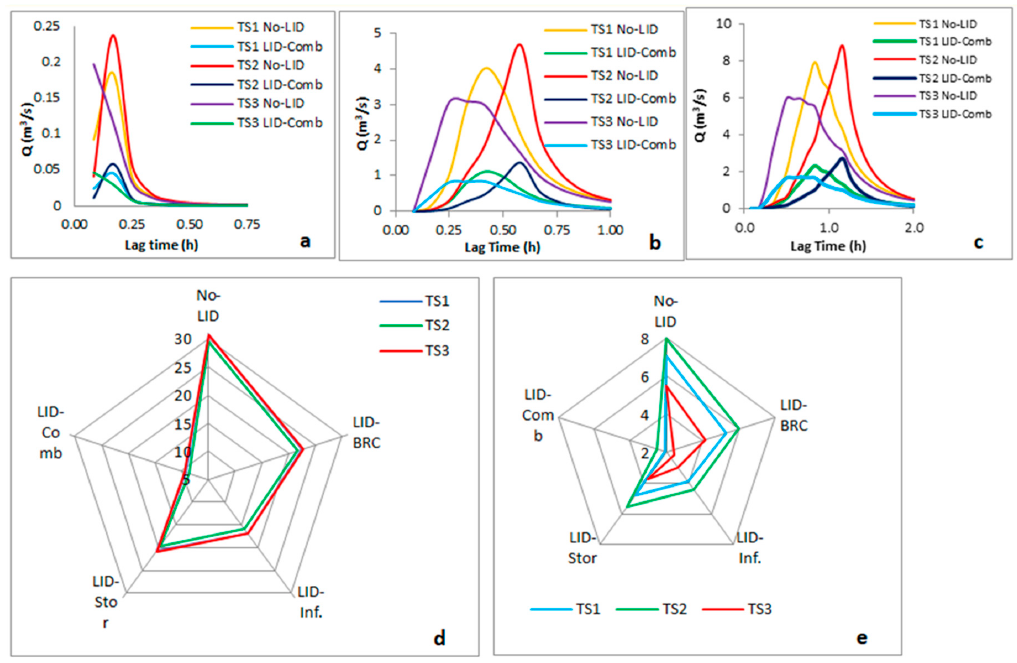
Figure 9. Effect of rainfall patterns on peak runoff magnitudes for storm durations of: ( a ) 10 min, ( b ) 30 min and ( c ) 1 h; ( d ) runoff volume and ( e ) average peak runoff .